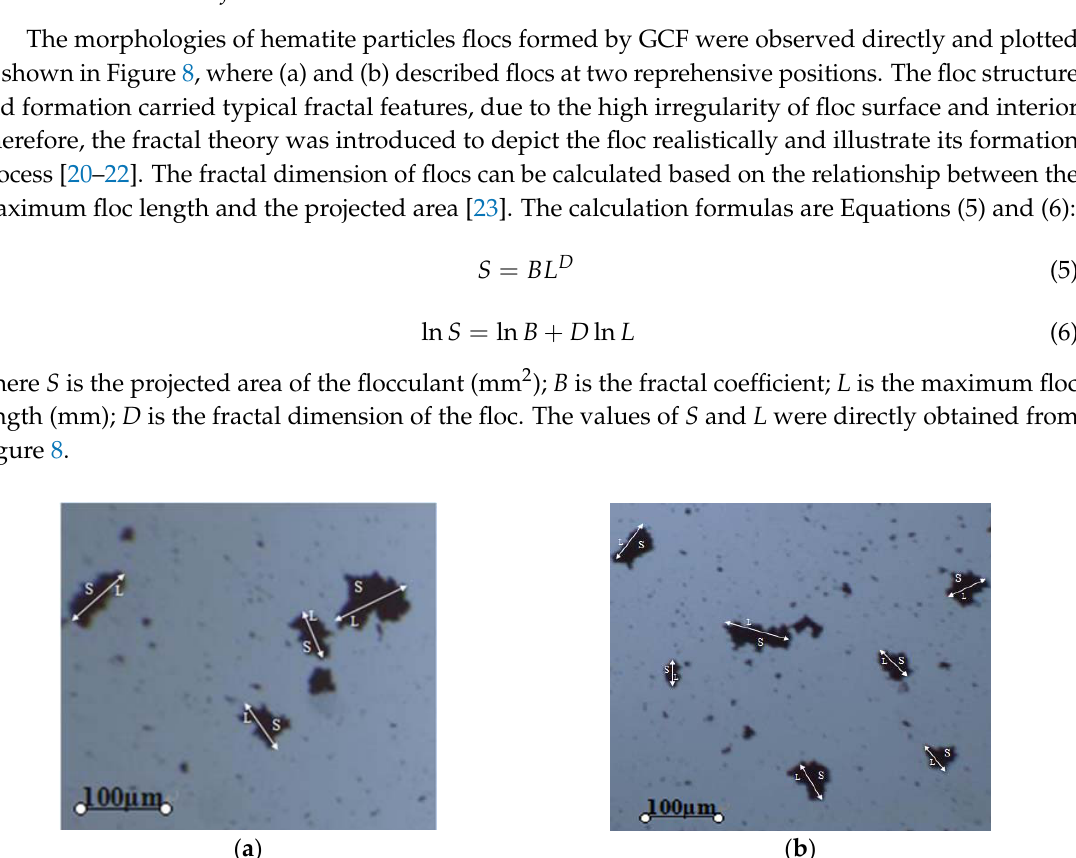
Figure 7. Effect of GCF concentration on the mean floc sizes.